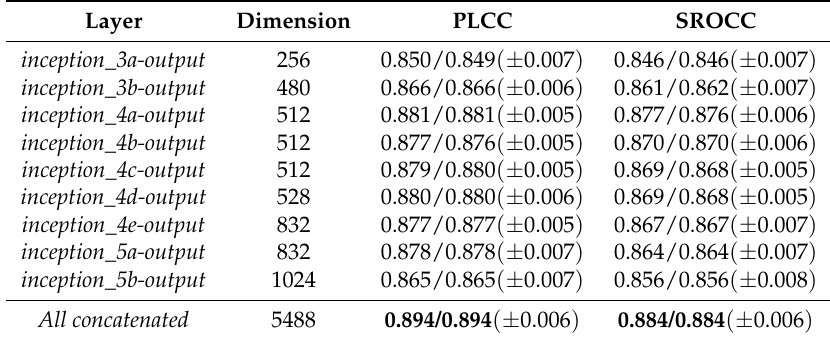
Table 2. Performance comparison of deep features extracted from GoogLeNet’s [31] Inception modules with fine-tuning measured on KonIQ-10k [33]. Average/median ( ± std ) values are reported over 20 random train–validation–test splits. The best results are in bold .